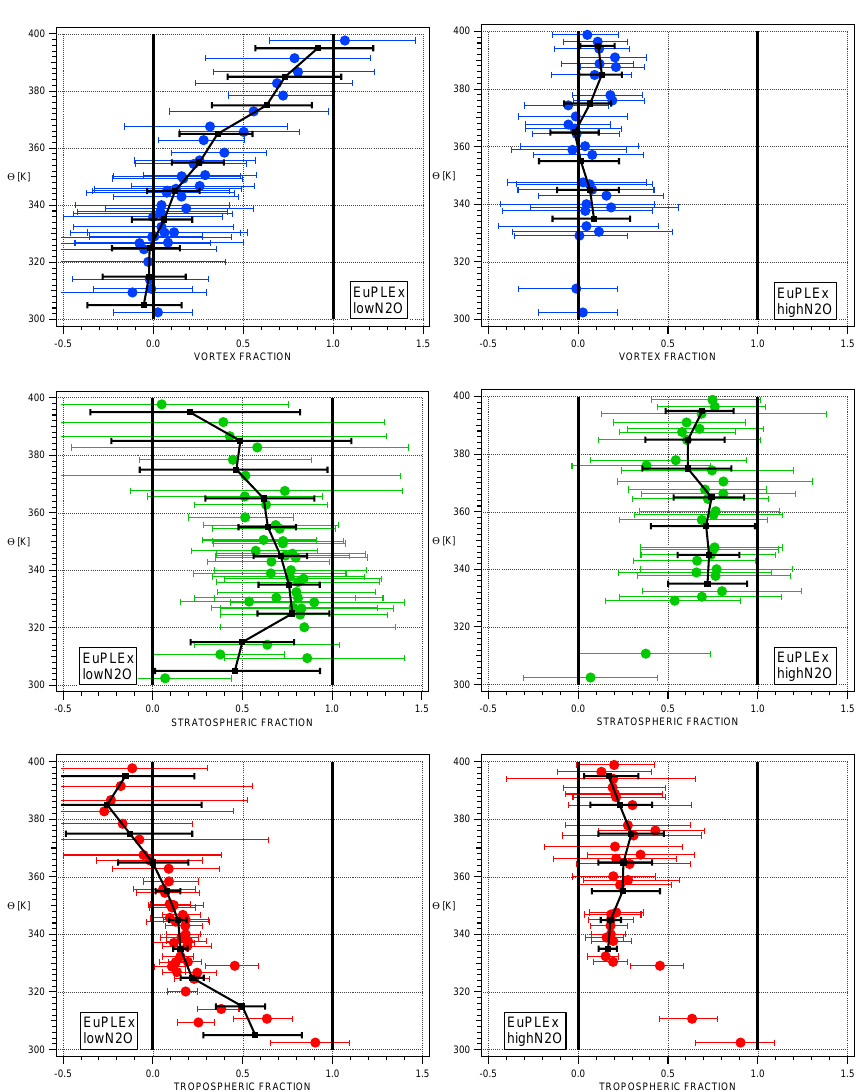
Fig. 8. Fractions of air in the LMS originating in the vortex (blue) region, the mid-latitude stratosphere (green) above 400K and in the troposphere (red). Results for the “low N 2 O data” set (left panel) and “high N 2 O data” set (right panel) are shown for the EuPLEx campaign. Error bars range from the 16th to the 84th percentile for the individual data points. The profile averaged over 10K bins is shown in black. √ n where n is the number of data points used for averaging in each Error bars of the average are divided by